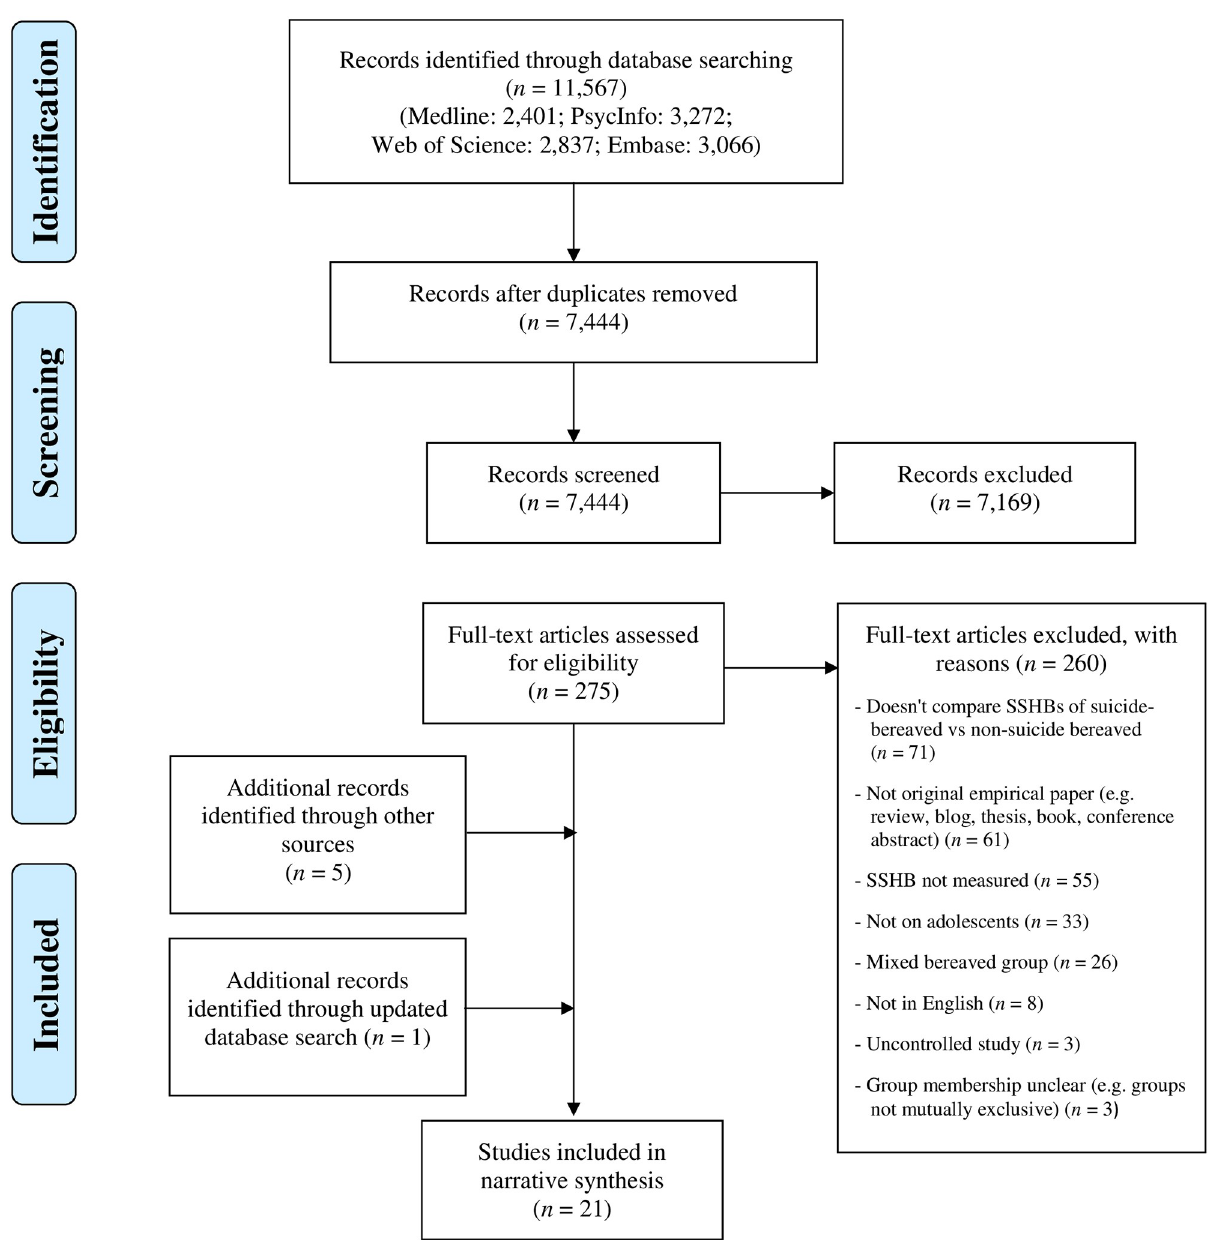
Fig 1. PRISMA flow diagram illustrating study selection process.